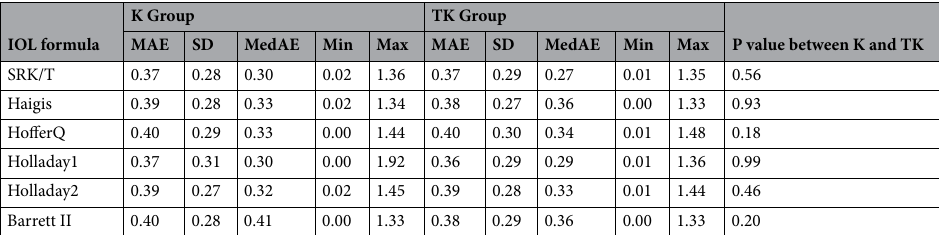
Table 2. Mean absolute errors (MAEs) and median absolute errors (MedAEs) for all formulas using keratometry (K) and total keratometry (TK) values. Wilcoxon signed-rank test for mean difference, all p values > 0.05 between the K and TK groups. Friedman test with Bonferroni post-hoc correction for multiple comparisons between IOL formulas, p value = .977. IOL intraocular lens, K keratometry, TK total keratometry.